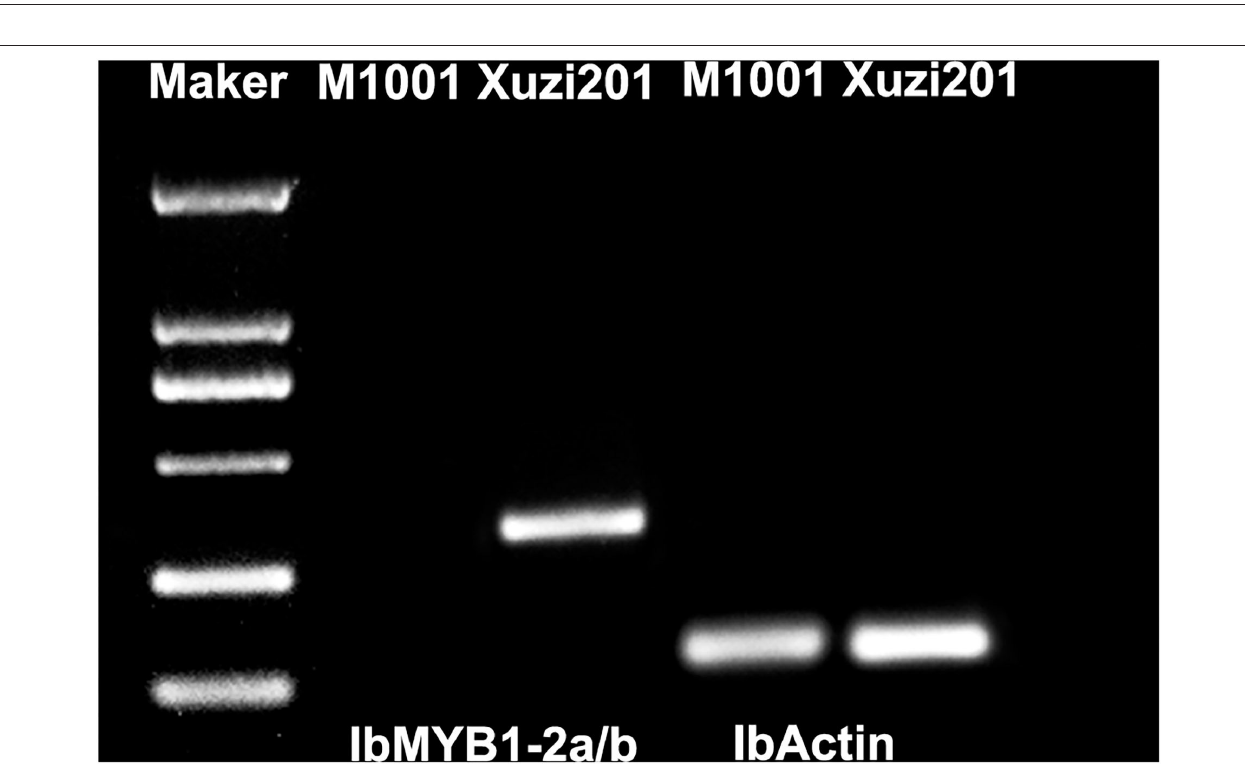
FIGURE 6 | sweet potato and its mutant. Metabolites in red and blue indicate up-accumulated and down-accumulated in M1001, respectively. The histogram presents the expression level of corresponding structural genes in two varieties, green bar means downregulated in M1001. Enzymes in this pathway are shown as follows: GOT2, aspartate aminotransferase; PAL, phenylalanine ammonia lyase; C4H, cinnamate 4-hydroxylase; 4CL, 4-coumarateCoA ligase; CHS, chalcone synthase; CHI, chalcone isomerase; F3H, flavanone 3-hydroxylase; F3 ′ H, flavonoid 3 ′ -hydroxylase; DFR, dihydroflavonol 4-reductase; ANS, anthocyanidin synthase;